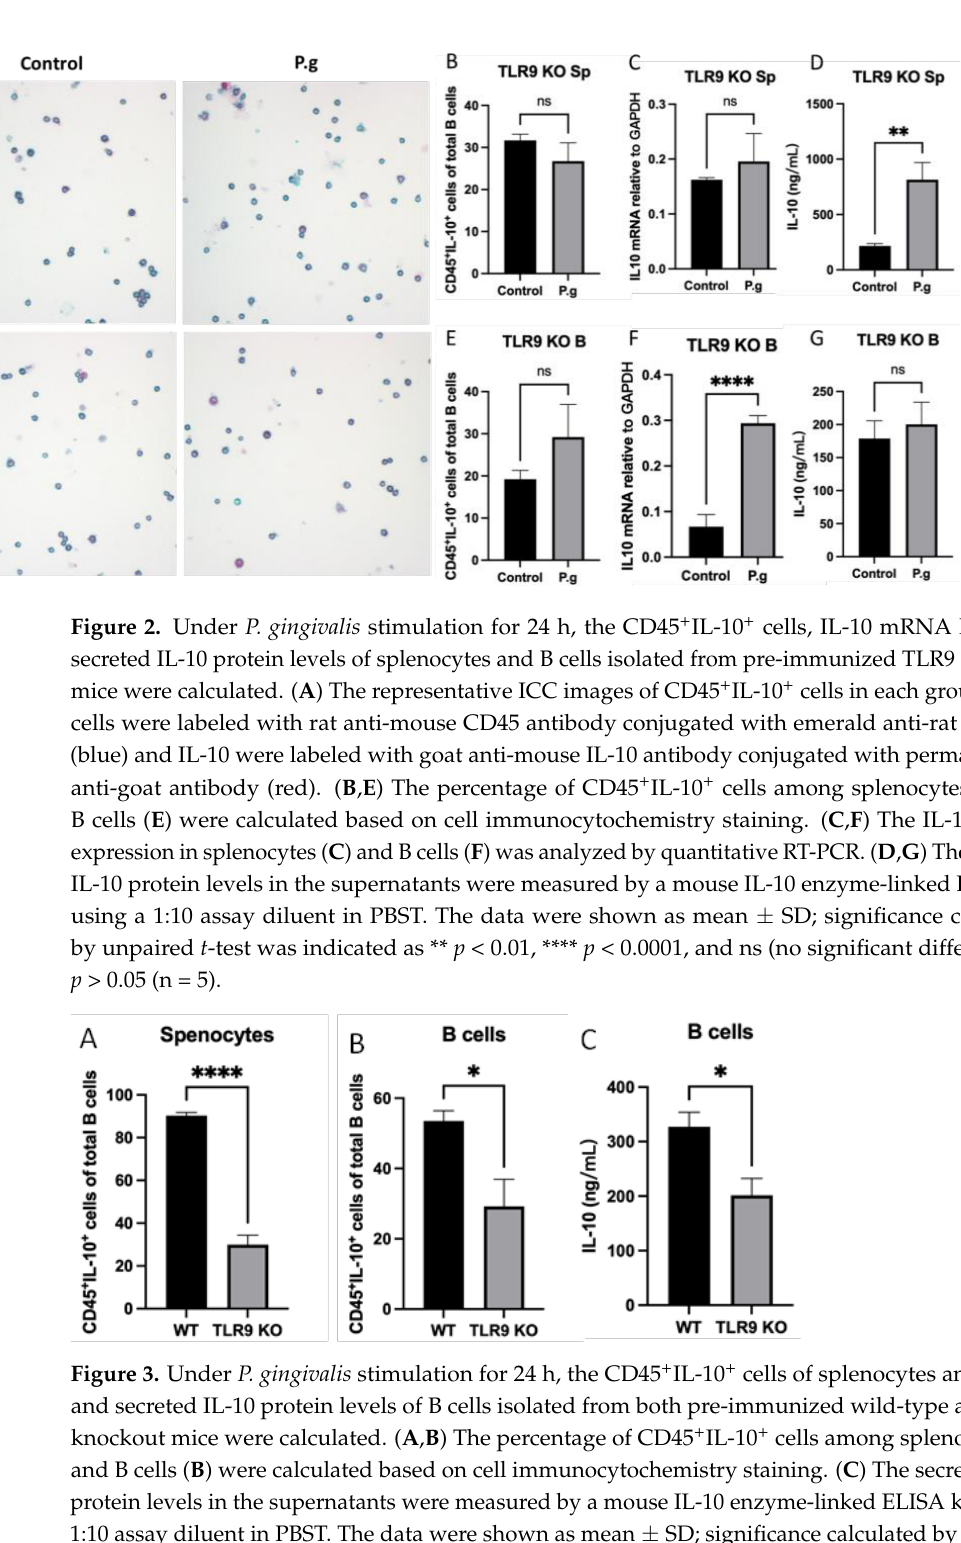
Figure 3. Under P. gingivalis stimulation for 24 h, the CD45 + IL-10 + cells of splenocytes and B cells, and secreted IL-10 protein levels of B cells isolated from both pre-immunized wild-type and TLR9 knockout mice were calculated. ( A , B ) The percentage of CD45 + IL-10 + cells among splenocytes ( A ) and B cells ( B ) were calculated based on cell immunocytochemistry staining. ( C ) The secreted IL-10 protein levels in the supernatants were measured by a mouse IL-10 enzyme-linked ELISA kit using a 1:10 assay diluent in PBST. The data were shown as mean ± SD; significance calculated by unpaired t -test was indicated as * p < 0.05, **** p < 0.0001 (n = 5).